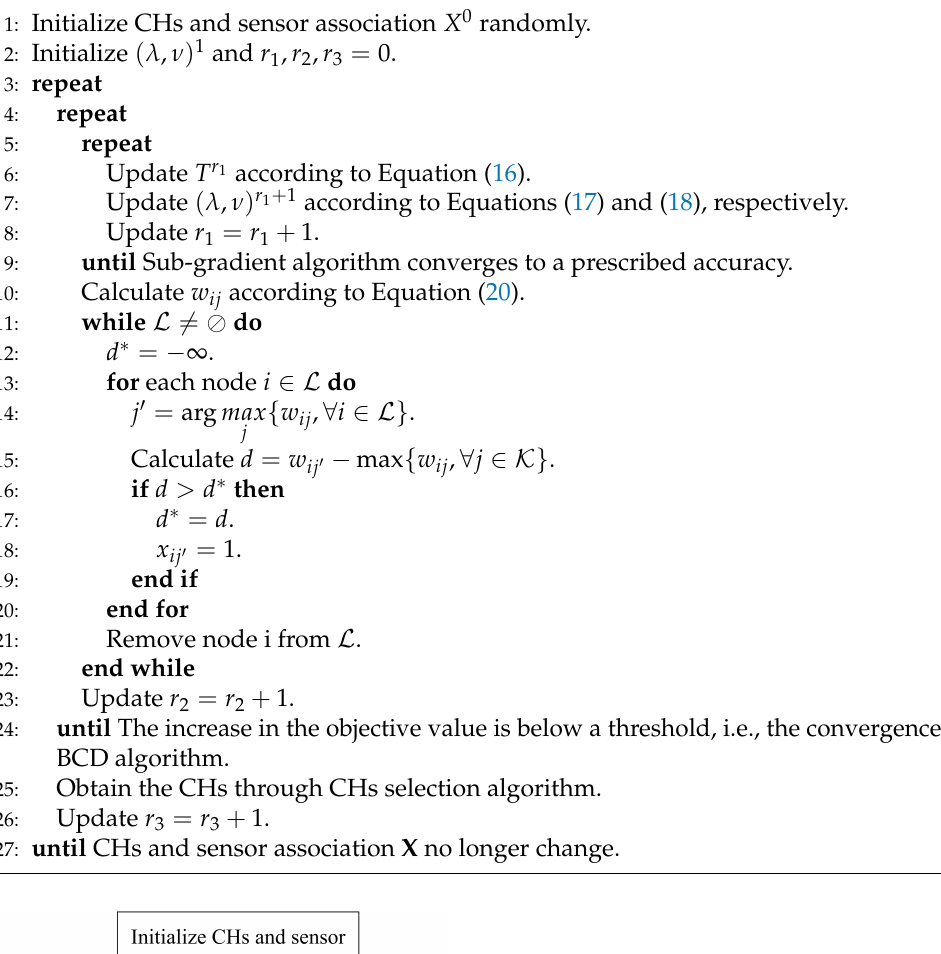
Algorithm 1 Acquisition Time and Sensor Association Optimization (ATSAO).